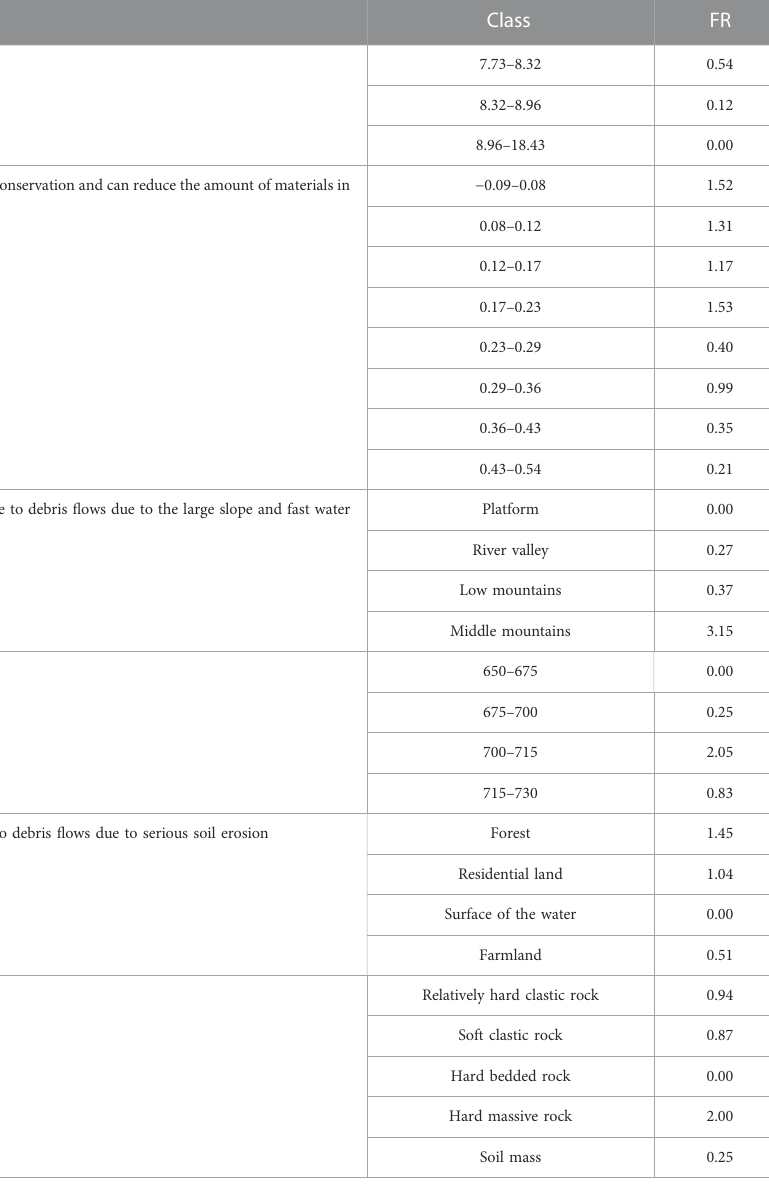
The NDVI re fl ectsvegetation coverage. High vegetation coverage is conducive tosoiland water conservation and can reduce theamount of materials in debris fl